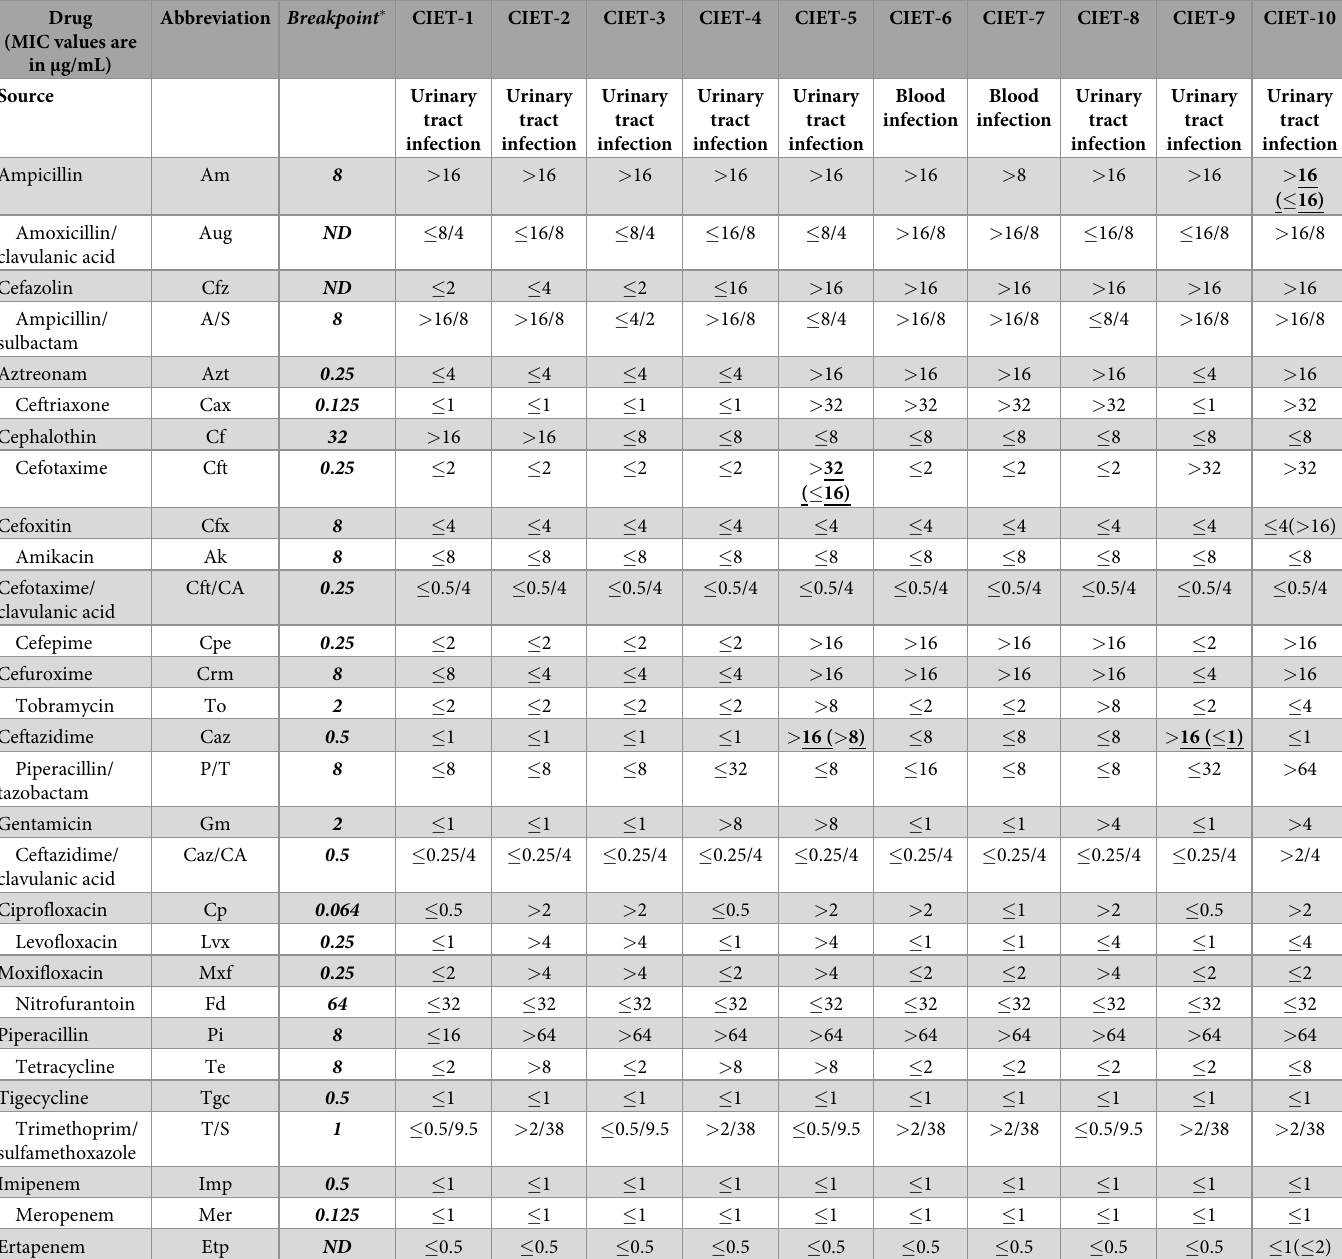
Table 1. MIC values obtained by iFAST and a standard clinical assay. Drug (MIC values